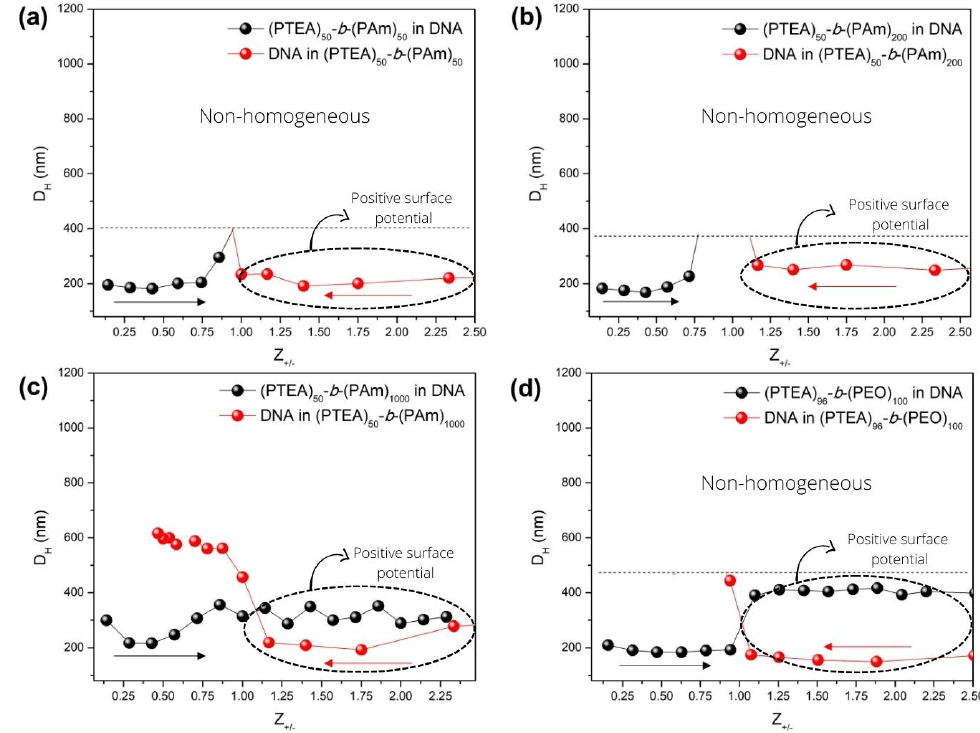
Figure 5. Size of polyplexes as function of charge ratio (Z +/ − ) for the addition of (PTEA) 50 - b -(PAm) 50 ( a ), (PTEA) 50 - b -(PAm) 200 ( b ), (PTEA) 50 - b -(PAm) 1000 ( c ), and (PTEA) 96 - b -(PEO) 100 ( d ) into DNA by direct addition (black) and addition of DNA into cationic block copolymer by reverse addition (red).